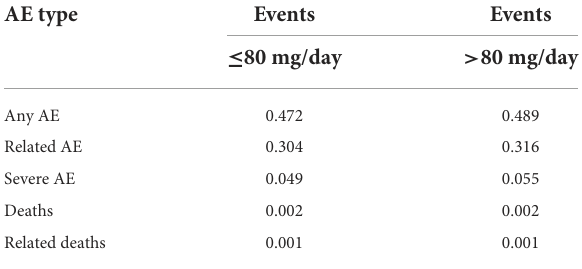
TABLE 6B Incidence of the number of adverse events/subject-year.